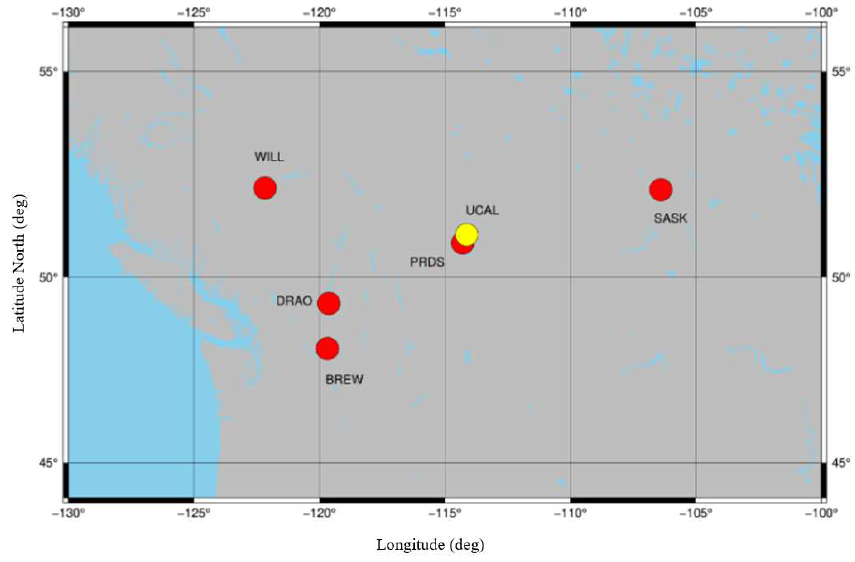
Figure 4. Distributions of the Chosen International GNSS Service (IGS)